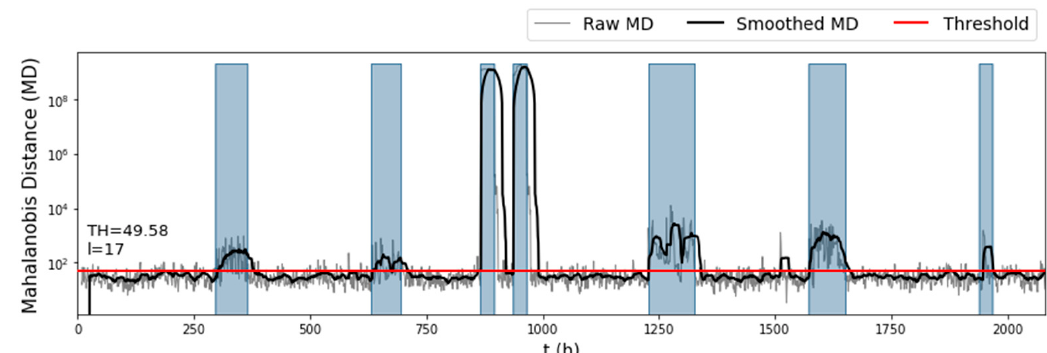
Figure 5. Mahalanobis distance on the test set ( Dataset 3 of BATADAL), before and after using a rolling mean window to avoid outliers.